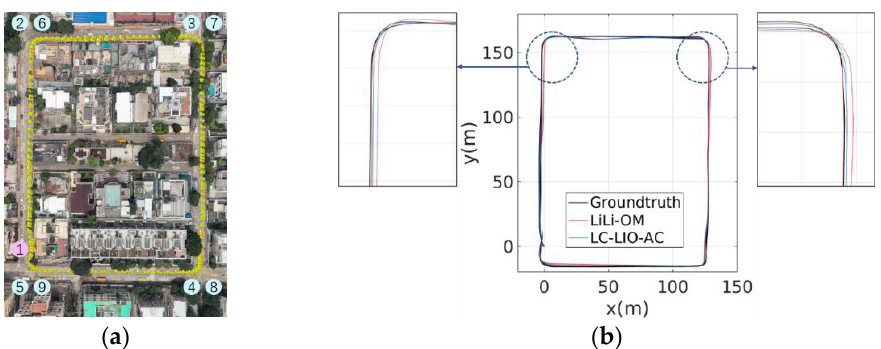
Figure 8. The trajectory of the dataset collected in the urban canyon 1: HK-Data20200314. ( a ) The ground truth aligned on Google Earth from the bird-eye view. The start point is represented with the pink circle with the number “1”. The other eight annotated places are the eight turns. ( b ) Trajectory comparison, the black trajectory is ground truth, the red and blue trajectories are estimated by LiLi-OM and LC-LIO-AC, respectively.